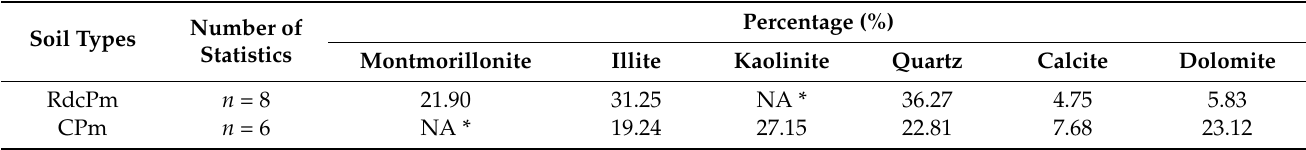
Figure 4. Composition types of minerals in two soil parent materials. ( a ) RdcPm; ( b ), CPm. Q: quartz; M: montmorillonite; I: illite; K: kaolinite; Ca: calcite; D: dolomite. Table 1. Mineral compositions of two soil parent materials.